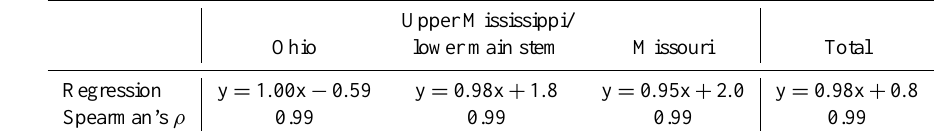
Table 3. Estimated discharge-measured discharge regressions.